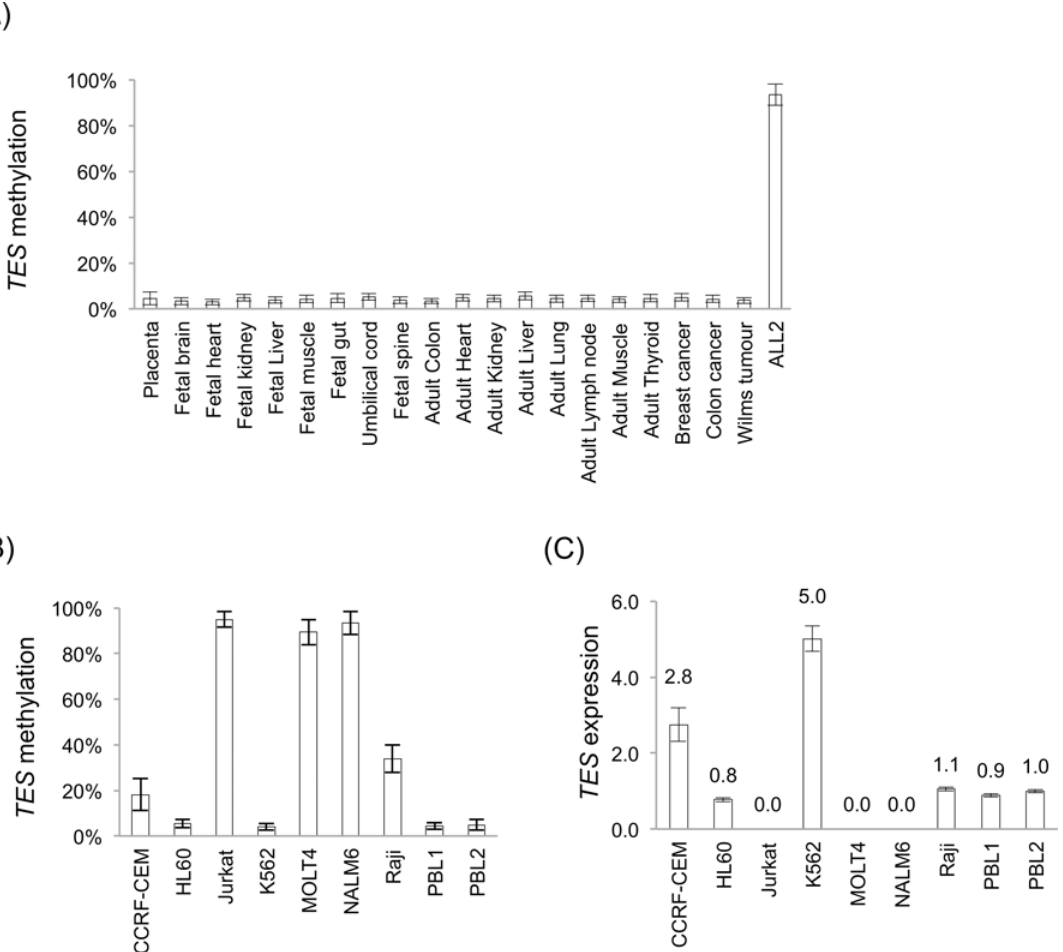
Fig 1. TES promoter methylation and expression. Sequenom MassARRAY methylation data of (A) normal, somatic tissues, and (B) lymphoblastoid cell lines (95% confidence intervals are shown). (C) TES expression levels by quantitative RT-PCR were calculated relative to B2M expression and normalised to relative expression levels in the normal peripheral blood leukocyte sample (PBL2) (error bars are standard deviations).